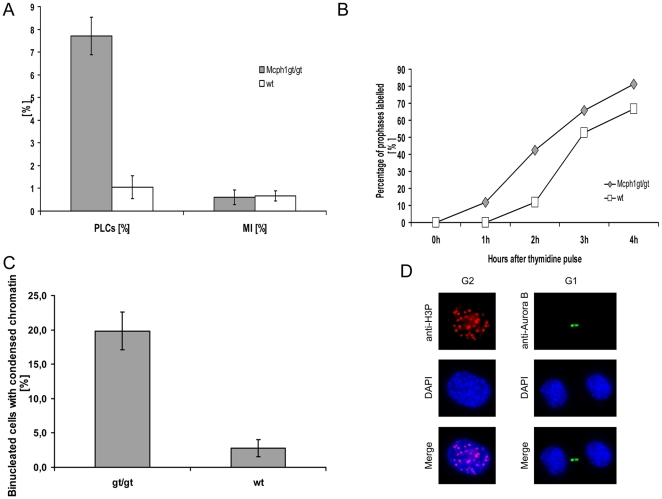
Analyses of chromosome condensation behavior in Mcph1 gt/gt cells.(A) Determination of the fraction of prophase-like cells (PLCs) and metaphase indices in Mcph1gt/gt and WT cell cultures. Mcph1gt/gt show significantly increased proportions of PLCs: 7.7% vs. 1.0% in WT cell cultures (χ2 = 1306.49, p<0.001). In contrast, metaphase indices (MI) are within the range of wild type cell cultures, indicating comparable proliferative activity. (B) Cell cycle analysis after 3H-thymidine-pulse-labeling of logarithmically growing fibroblast cell lines from Mcph1gt/gt (grey diamonds) and WT animals (white squares). The first labeled cells with prophase-like appearance in the Mcph1gt/gt cells occur within the first hour after the pulse. (C) Proportion of cells with condensed chromosomes postmitosis in Mcph1gt/gt and control cells. Many Cytochalasin-treated binucleated G1-cells of Mcph1gt/gt cells show condensed chromatin (19.8%) compared with control cells (2.8%). (D) To the left one exemplary cell displaying premature chromosome condensation in the G2 phase of the cell cycle defined by focal (centromeric) staining of phosphorylated histone H3(-Ser10), note that the phosphorylation has not spread into the chromosome arms. To the right two cells showing delayed decondensation in G1 post-mitosis defined by the formation of a midbody.